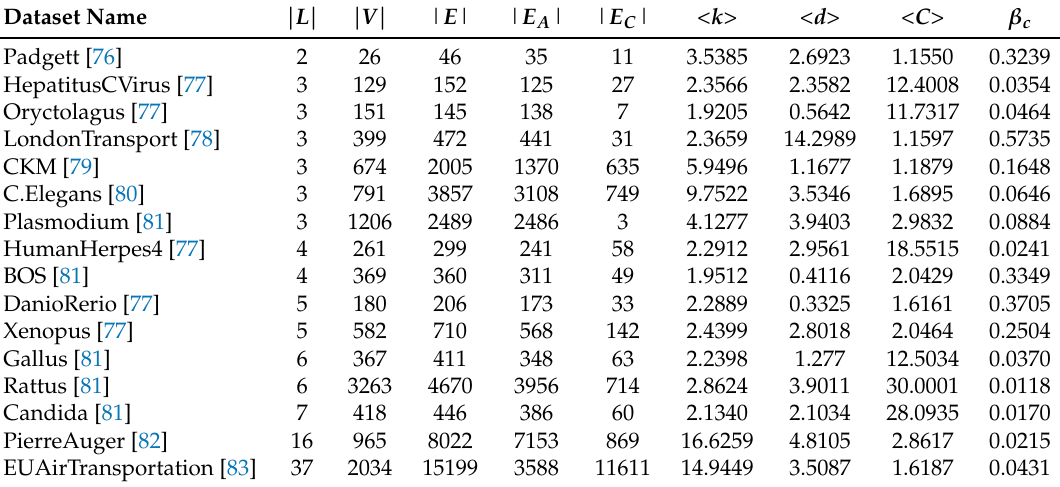
Table 3. Statistics of 16 multilayer datasets that are utilized in this